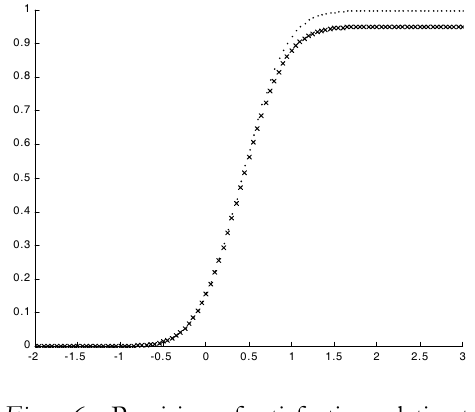
Figure 6 – Prevision of satisfaction relative to